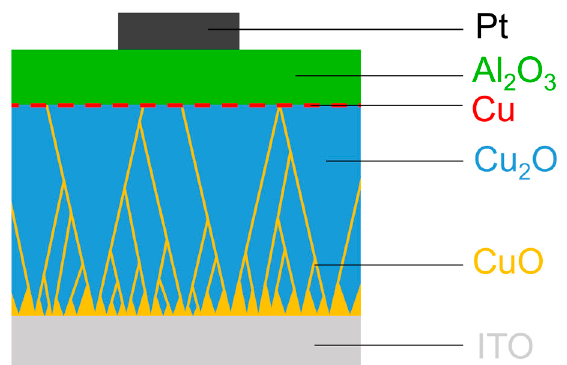
Figure 1. Device structure in cross-sectional view. The inhomogeneities in the copper oxide are schematically shown in orange (CuO-containing grain boundaries) and red (metallic copper at the interface between Al 2 O 3 and Cu 2 O).